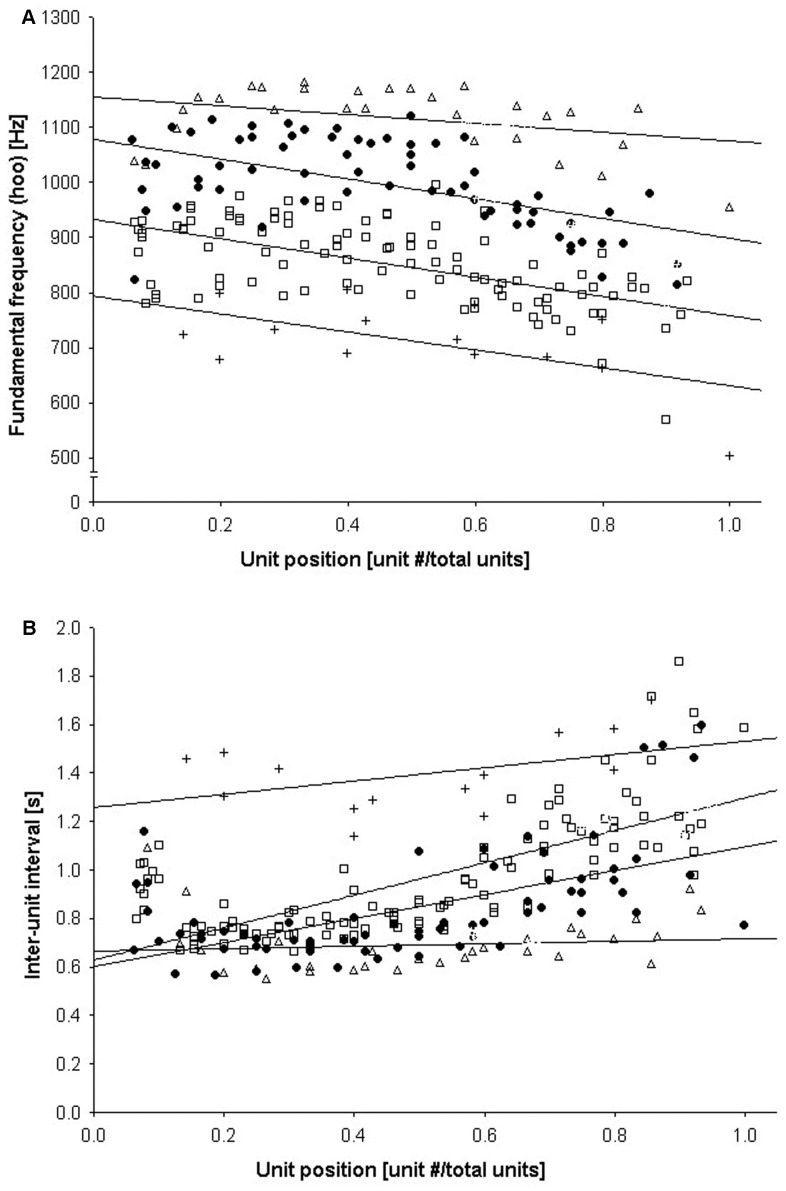
Changes in call characteristics as a function of unit position: (A) fundamental frequency of the hoo syllable and (B) inter-unit interval.Best-fit lines for individual males provided for demonstration purposes only.